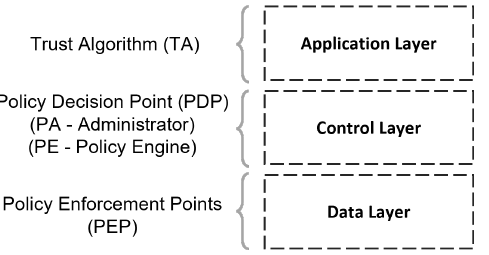
Figure 8. SDN Platform mapping to Zero-Trust